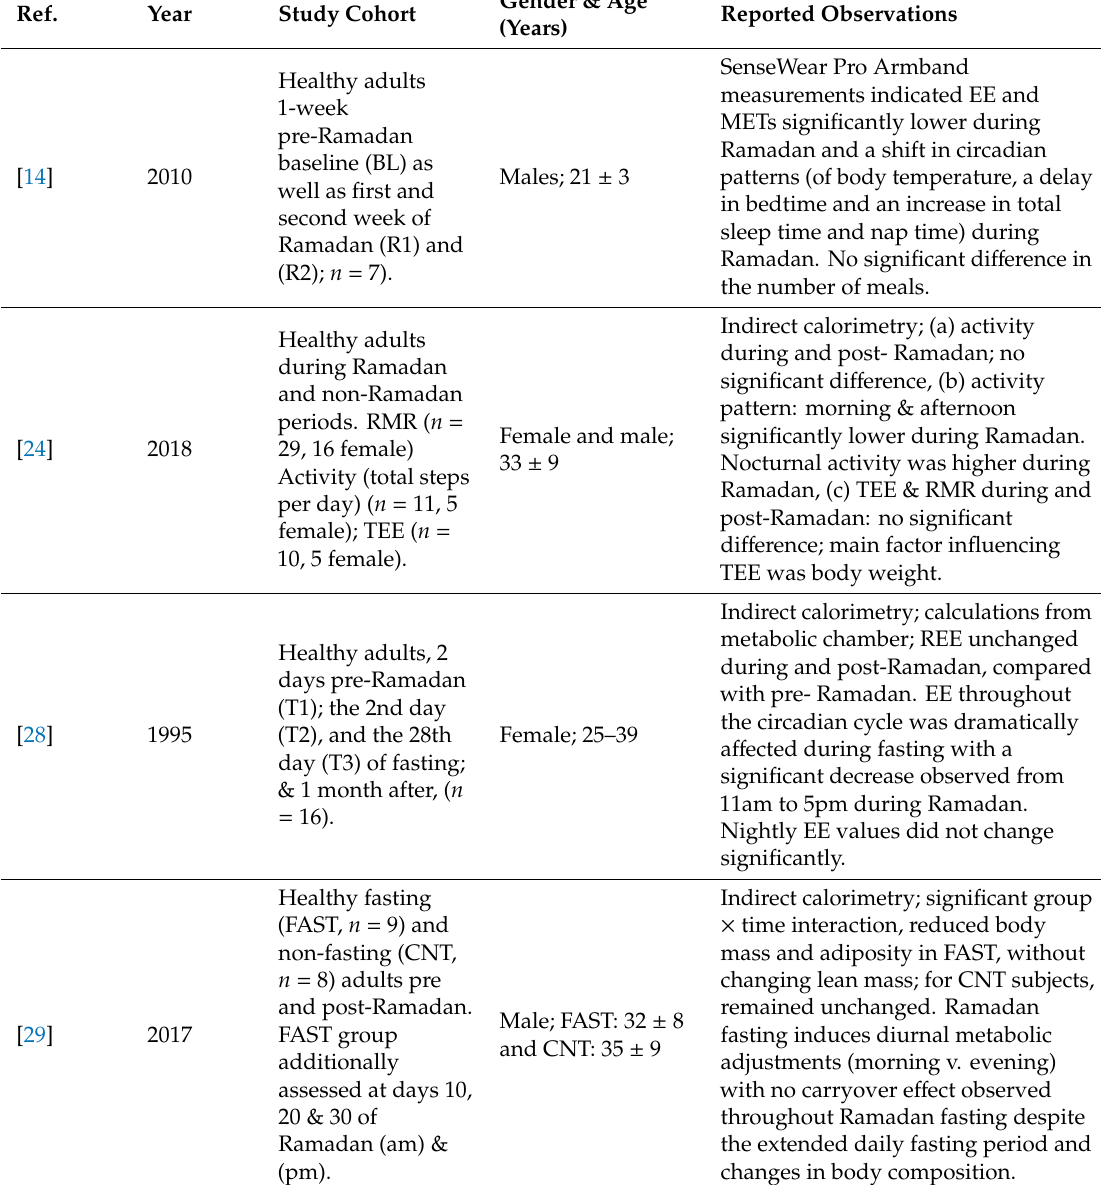
Table 1. Energy Expenditure in